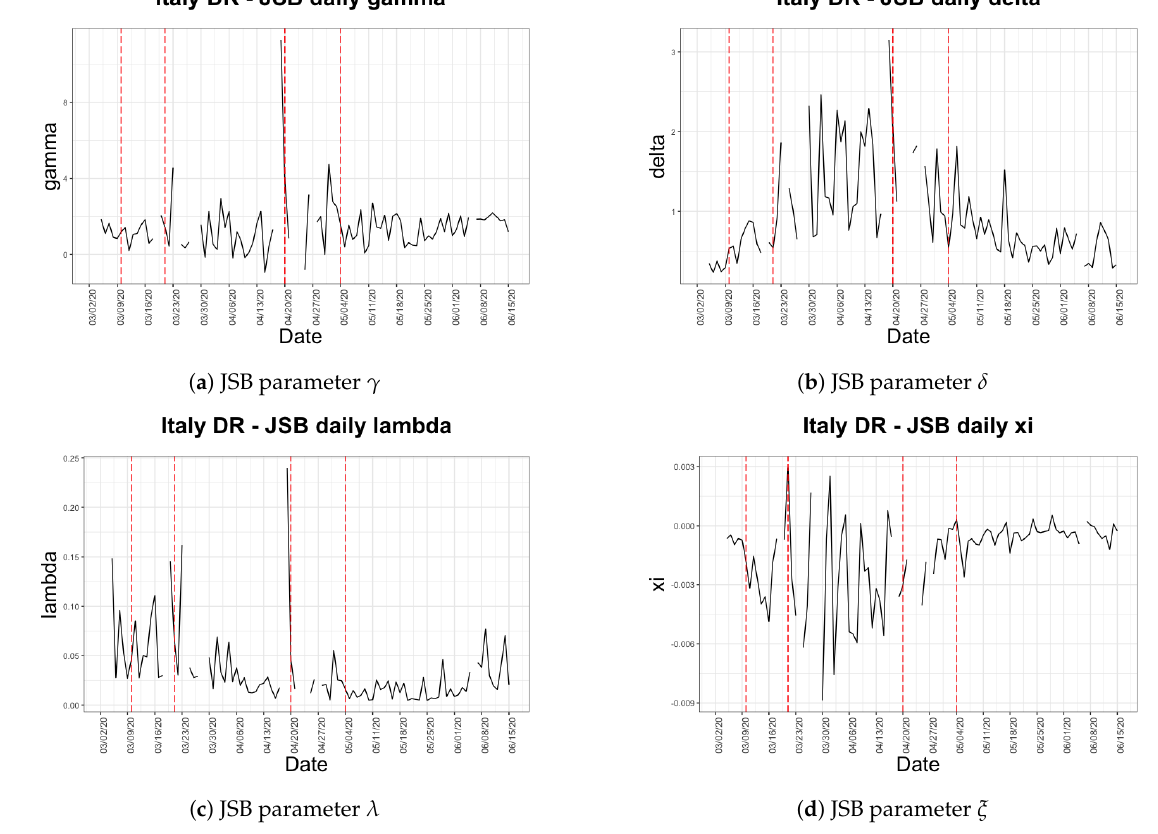
Figure 10. Time series for Italy death rate Johnson S B